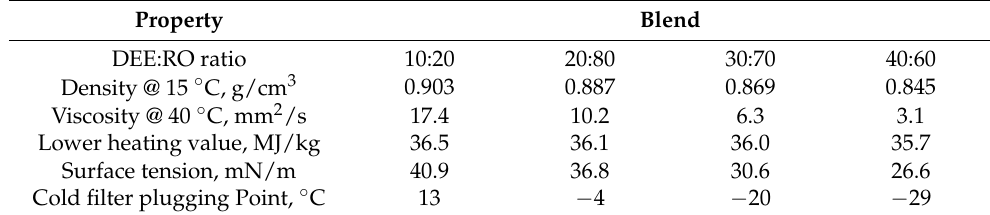
Table 4. Physicochemical specification of tested blends.